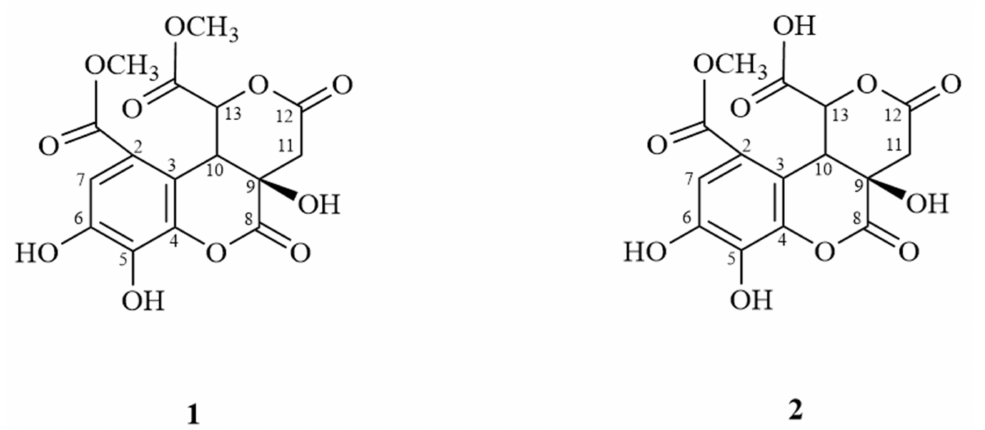
Figure 1. Structures of compounds 1 and 2